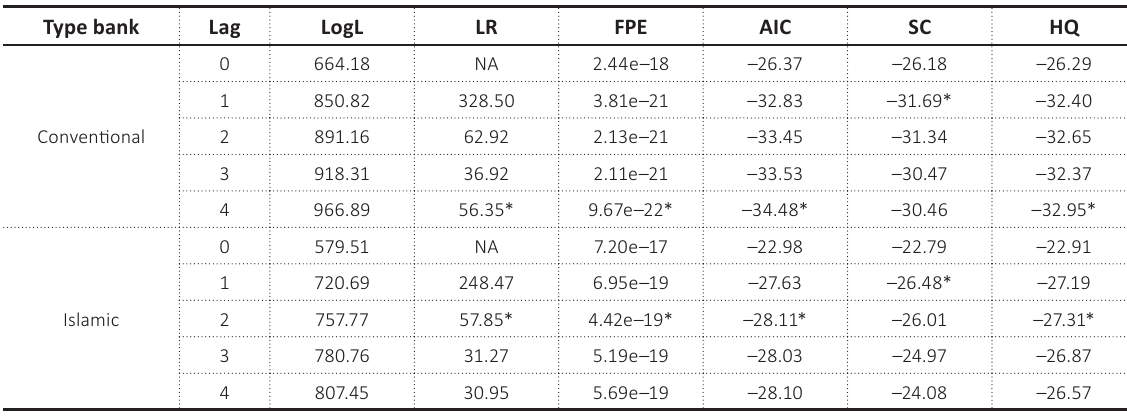
Table A2. Lag optimum test result